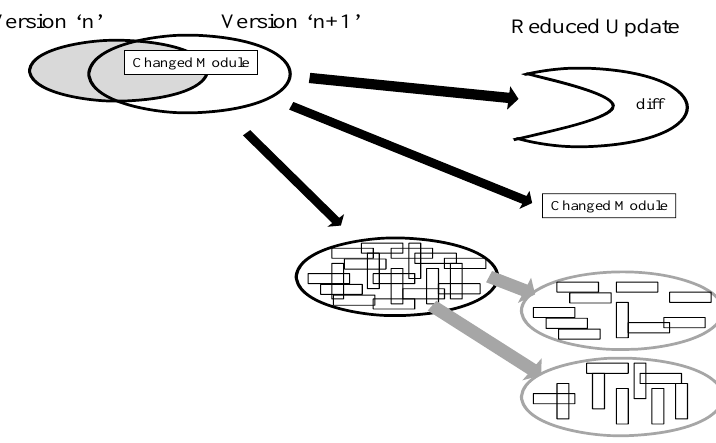
Figure 4. Update Traffic Reduction